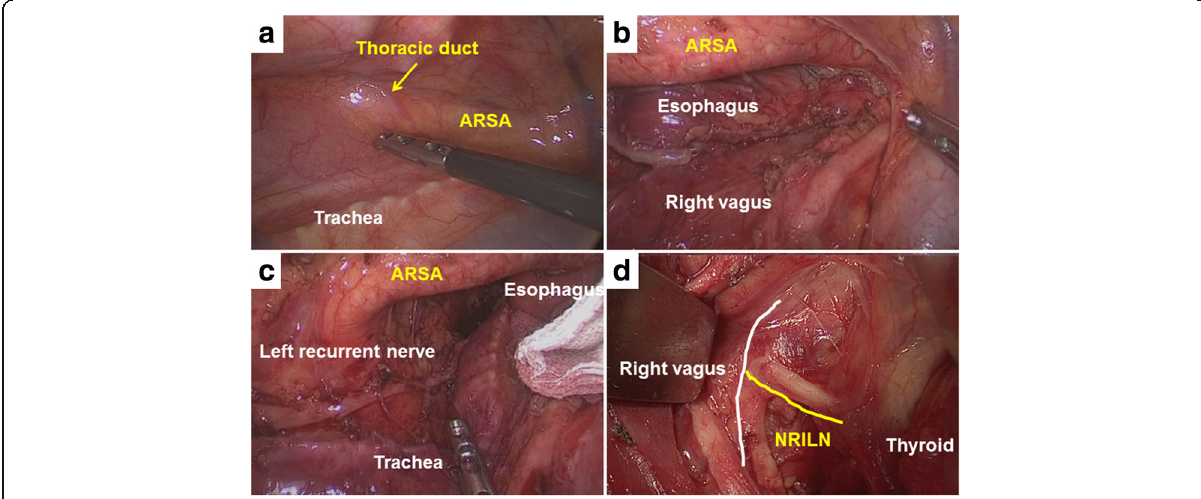
Fig. 3 Case 2, intraoperative findings. a The right thoracic duct coursed across the aberrant right subclavian artery and esophagus, running into the right venous angle. b The right recurrent nerve was not evident. c The left recurrent nerve was normal, and the space in the upper mediastinum on left side was restricted by the aberrant right subclavian artery. d In the neck, the nonrecurrent right inferior laryngeal nerve headed into the larynx directly from the vagus